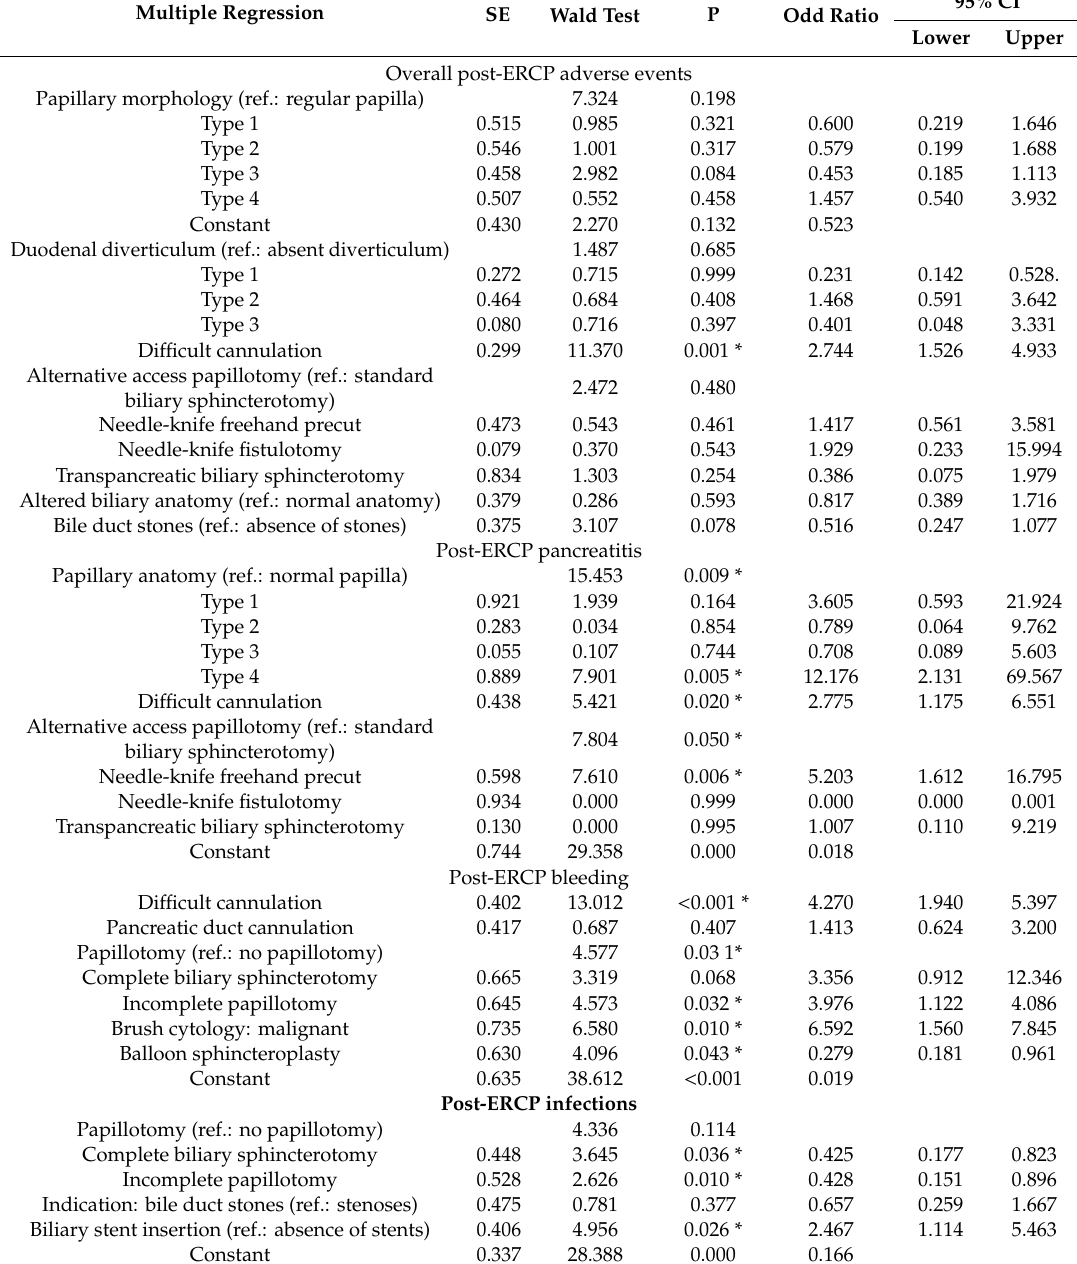
Table 6. Multiple regression. Identification of procedure-related risk factors for post-ERCP adverse events. Multiple